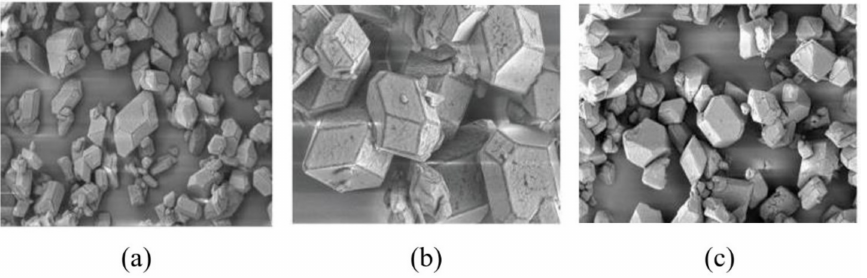
Figure 8. Crystal morphology of β -HMX induced by additives PAA, PEI, and PVA at 298 K ( a ) PAA-induced, ( b ) PEI-induced, and ( c ) PVA-induced [38].